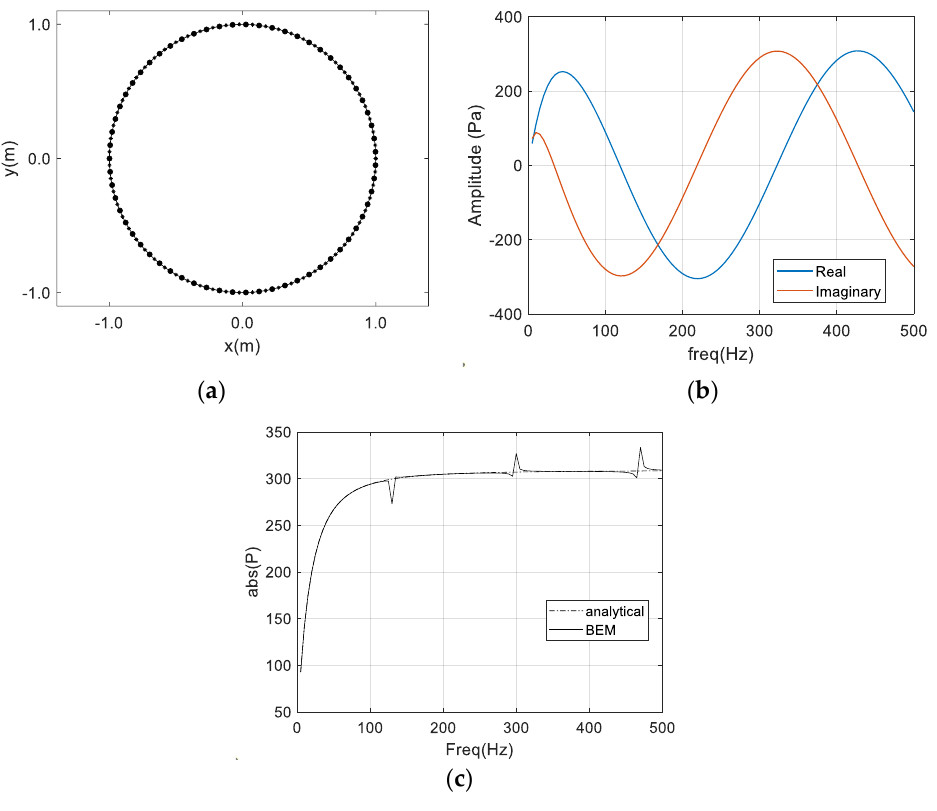
Figure 4. Test case with a circular cavity with prescribed particle velocity: ( a ) BEM discretization with 63 constant elements; ( b ) real and imaginary parts of the analytical solution; ( c ) absolute value of the pressure solution considering analytically and numerically (with the BEM) computed responses.